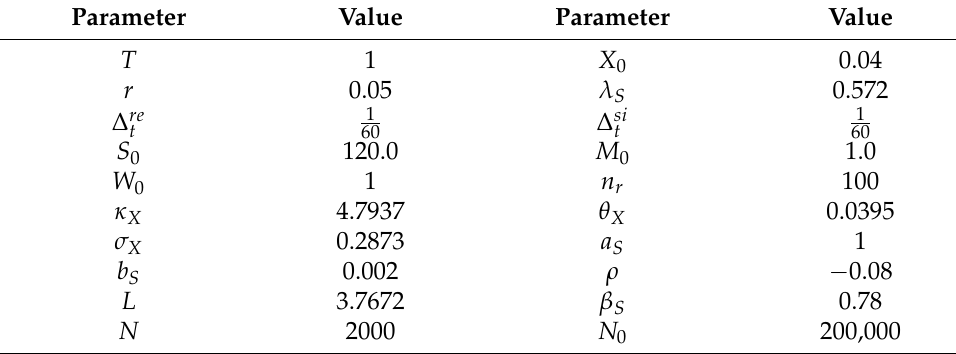
Table 6. Parameter value for the OU 4/2